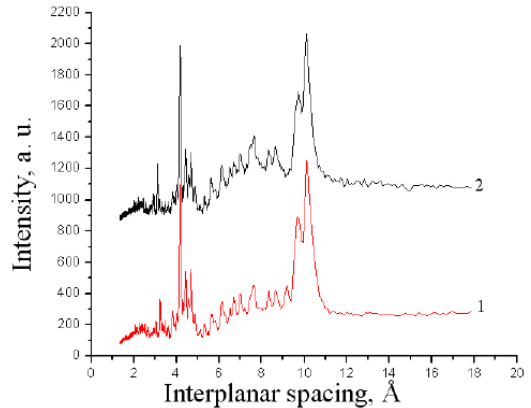
Figure 1. X-ray diffractograms of “wet” produced Eu(TTA)